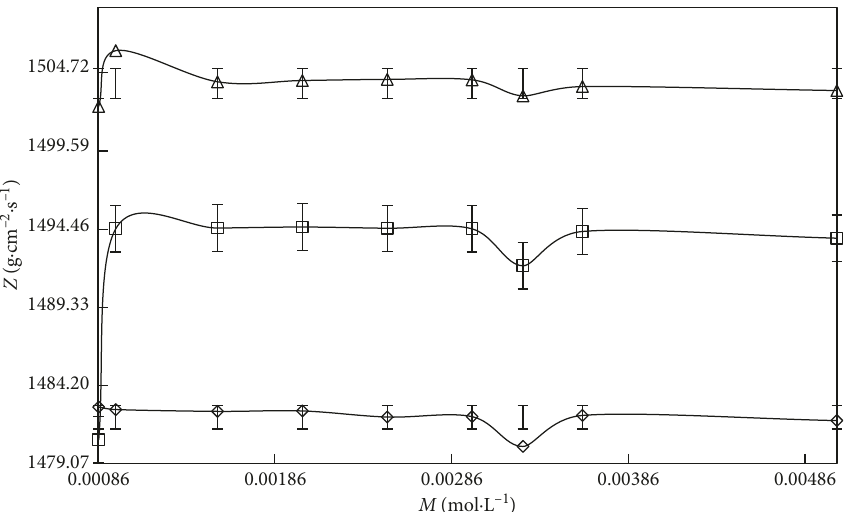
Figure 5: The Z value of the DTAB-rich surfactant at the three different temperatures T � 293.15 ( ◊ ), 298.15 ( □ ), and 303.15K ( △ ),